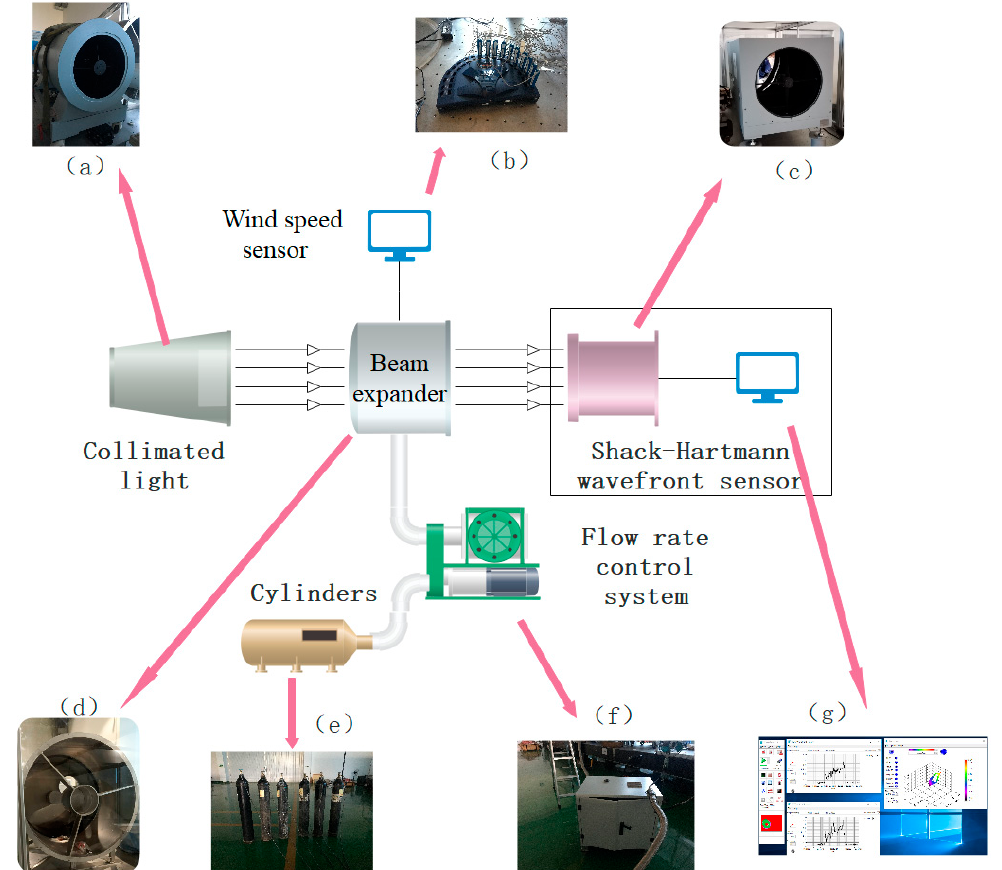
Figure 9. Experimental platform and equipment: ( a ) collimator; ( b ) wind speed sensor; ( c ) Shack–Hartmann wavefront sensor; ( d ) beam expander; ( e ) cylinders; ( f ) flow rate control system; ( g ) screen.